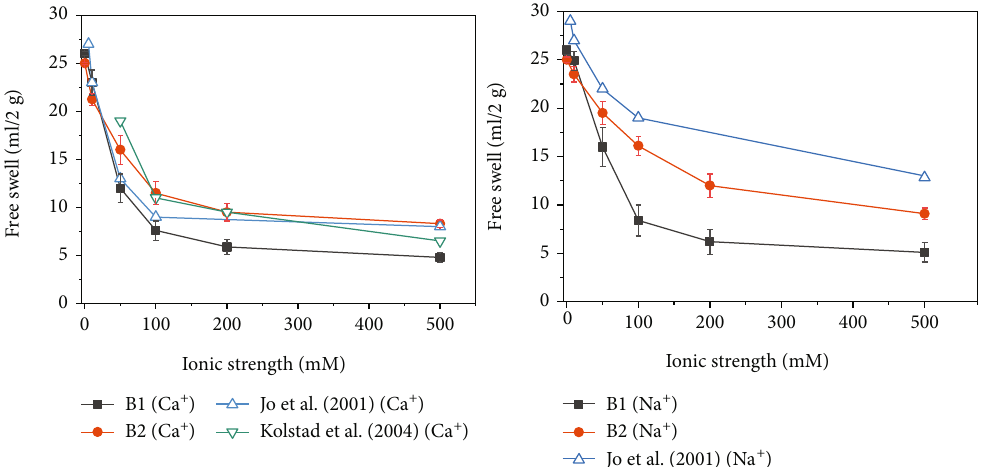
Figure 4: Free swell of bentonite as a function of di ff erent ionic strengths.